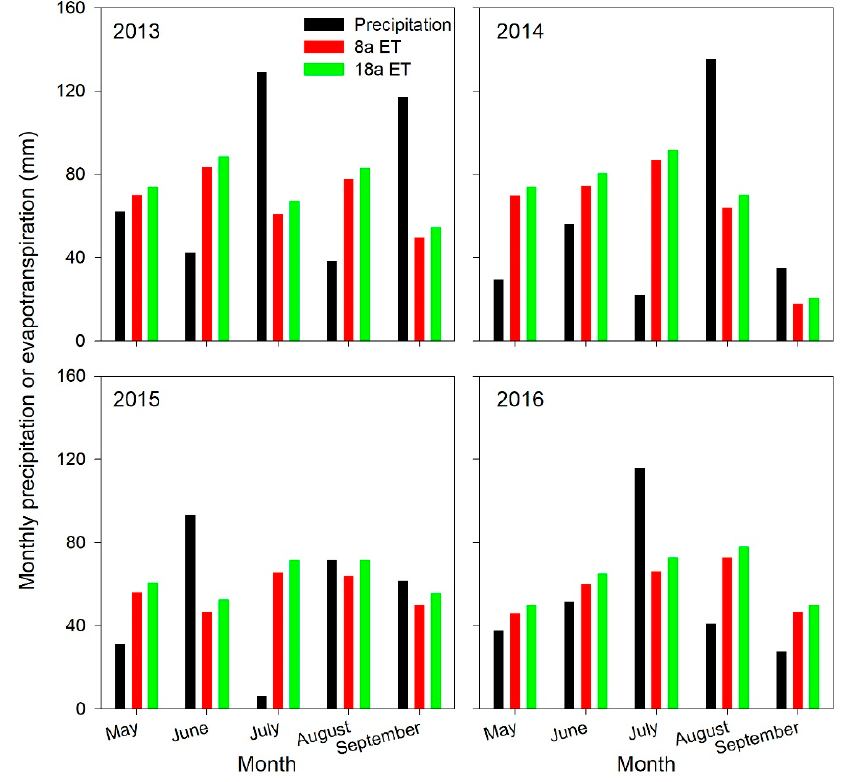
Figure 3. Monthly precipitation and evapotranspiration (ET) for the 8- and 18-year-old apple orchards (8a and 18a, respectively) in 2013, 2014, 2015, and 2016. Forests 2020 , 11 , x FOR PEER REVIEW